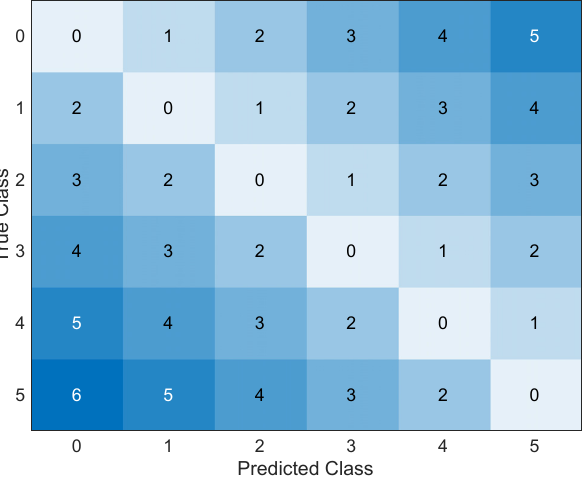
Figure 9. Penalty matrix.